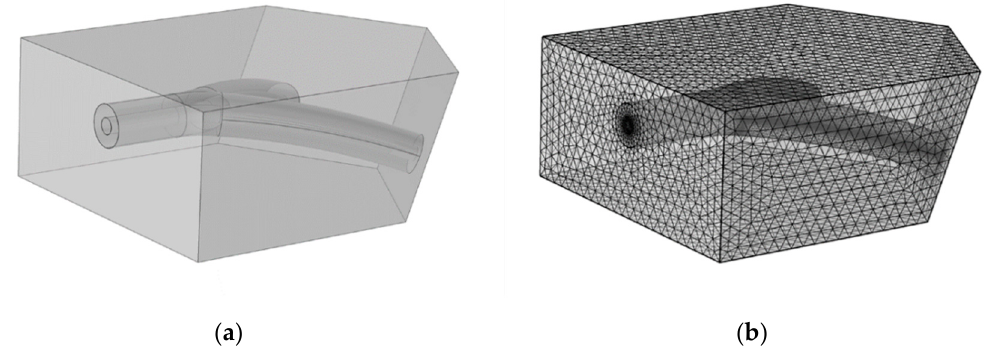
Figure 2. ( a ) The geometry of the bioengineered vascular construct embedded in the cardiac muscle used for the simulations, and ( b ) the mesh model created for the simulation.